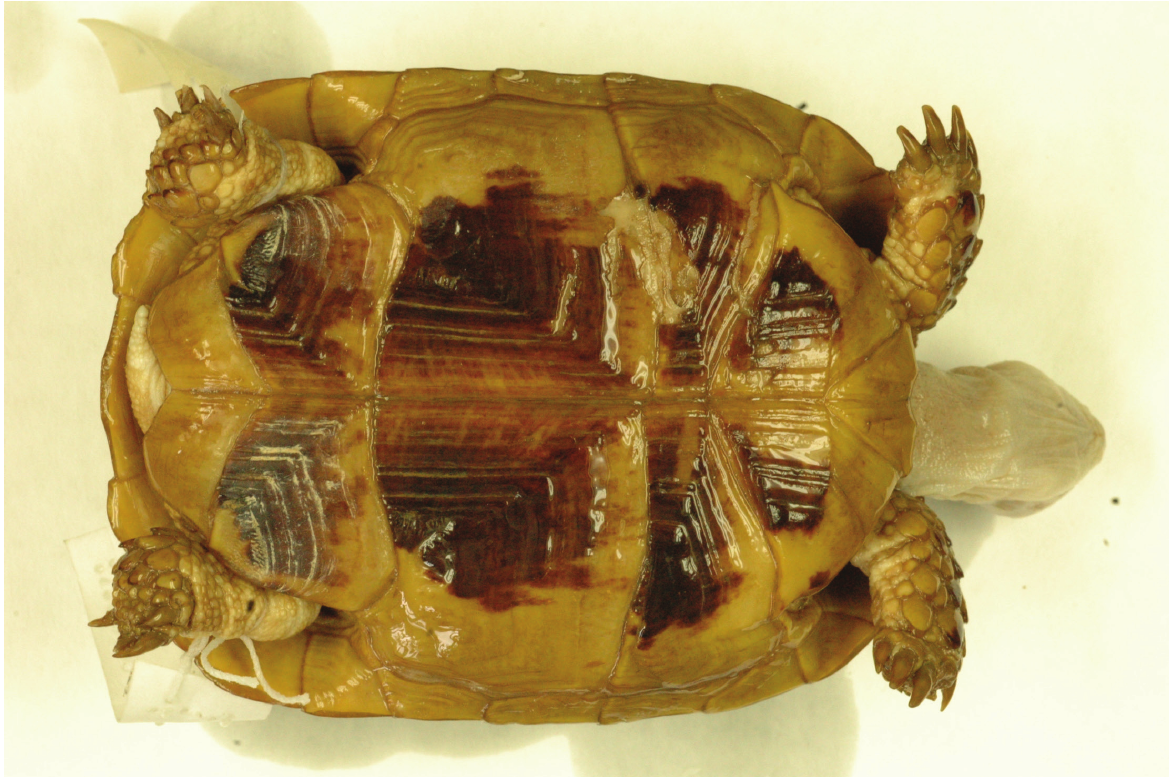
Figure 4. MNHN 0.1937., designated Neotypus of Testudo graeca mauritanica , ventral. (Photograph: A.